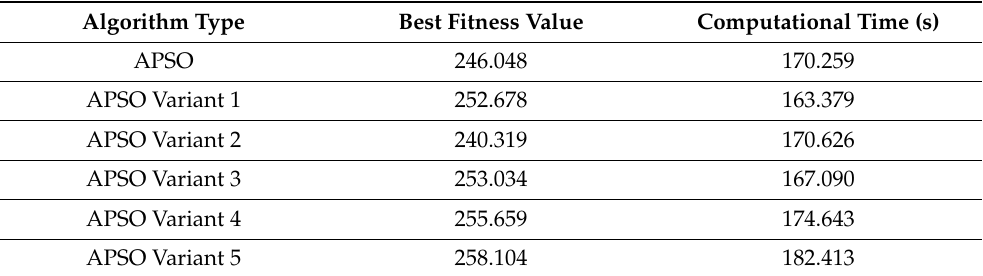
Table 15. Summarized results for APSO and its variants for 1000 PHEVS.